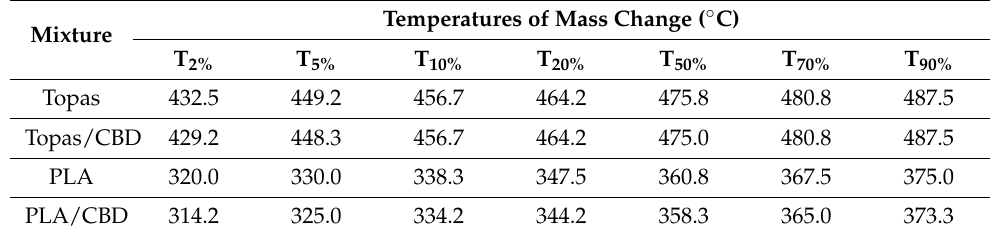
Table 2. Temperatures of the mass loss of tested materials, where T x% is a temperature at which the mass change is x% (2, 5, 10, 20, 50, 70, 90%, respectively). Temperatures of Mass Change ( ◦ C) Mixture T 2% T 5% T 10% T 20% T 50% T 70% T 90% Topas 432.5 449.2 456.7 464.2 475.8 480.8 487.5 Topas/CBD 429.2 448.3 456.7 464.2 475.0 480.8 487.5 PLA 320.0 330.0 338.3 347.5 360.8 367.5 375.0 PLA/CBD 314.2 325.0 334.2 344.2 358.3 365.0